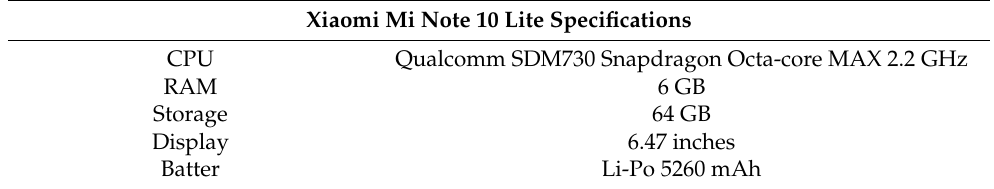
Table 8. Mobile device specifications.